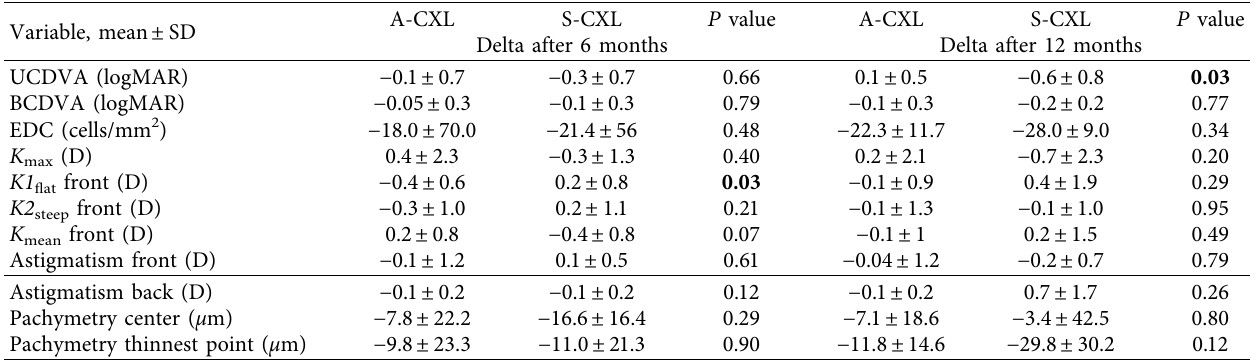
Table 2: Intergroup comparison of the delta in outcomes at 6 and 12 months after the procedure.